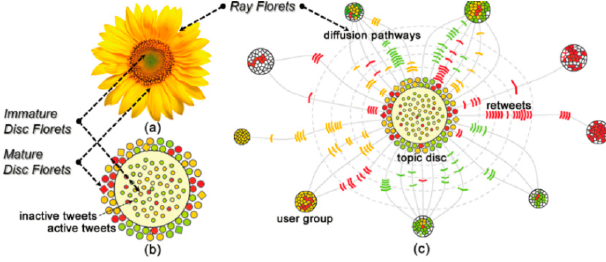
Figure 1. Visual metaphors of Whisper [2].